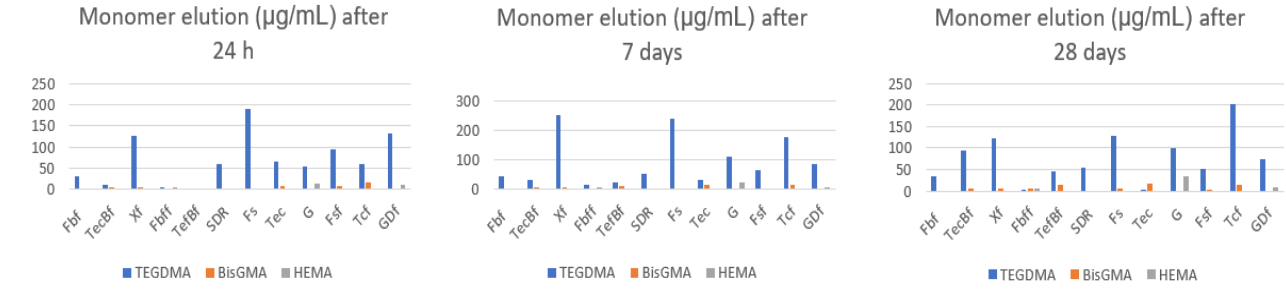
Figure 2. Mean amounts of leached TEGDMA, Bis GMA and HEMA at different time point. Fbf (Filtek Bulk Fill) TecBf (Tetric Evo Ceram Bulk Fill) Xf (X-tra Fil) Fbff (Filtek Bulk Fill flow) TefBf (Tetric EvoFlow Bulk Fill) SDR (SDR) Fs (Filtek Supreme) TeC (TetricEvo Ceram) G (Gradia) Fsf (Filtek Supreme flow) Tcf (TetricEvo flow) GDf (Gradia Direct flo). TEGDMA (Triethylene glycol